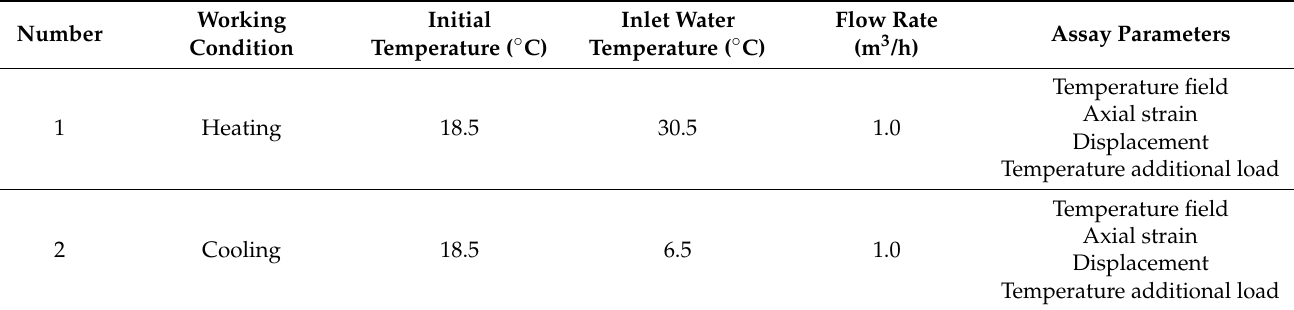
Table 4. Numerical simulation test scheme of deep buried pipe energy